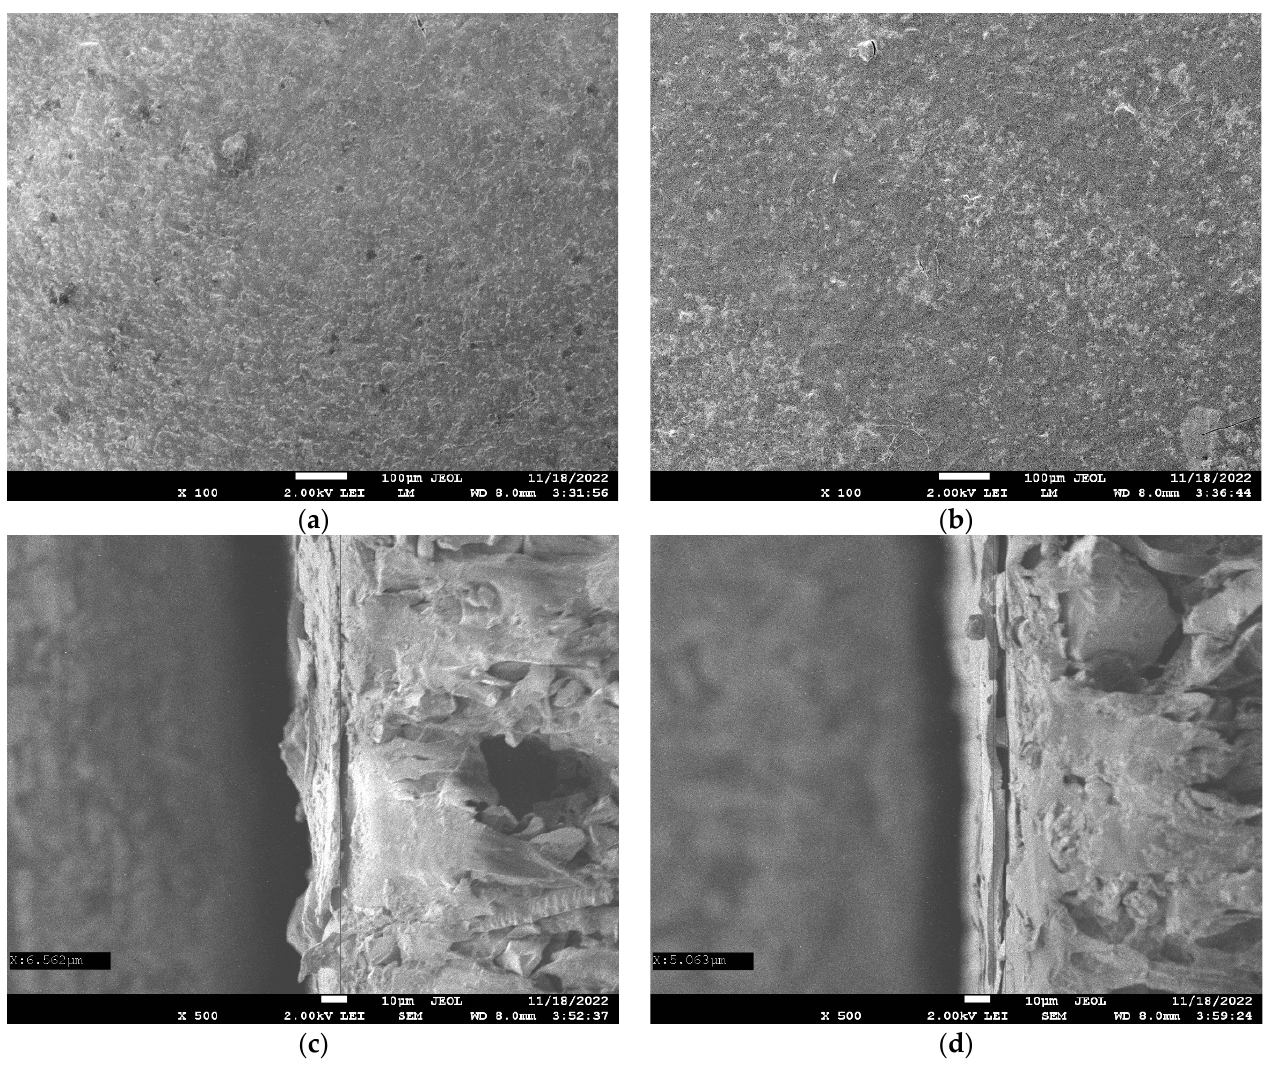
Figure 3. Top views ( a , b ) and cross sections of newly prepared MK-40-M (PAH) ( a , c ) and MK-40-M (PEI) ( b , d ) membranes imaged as dry samples.